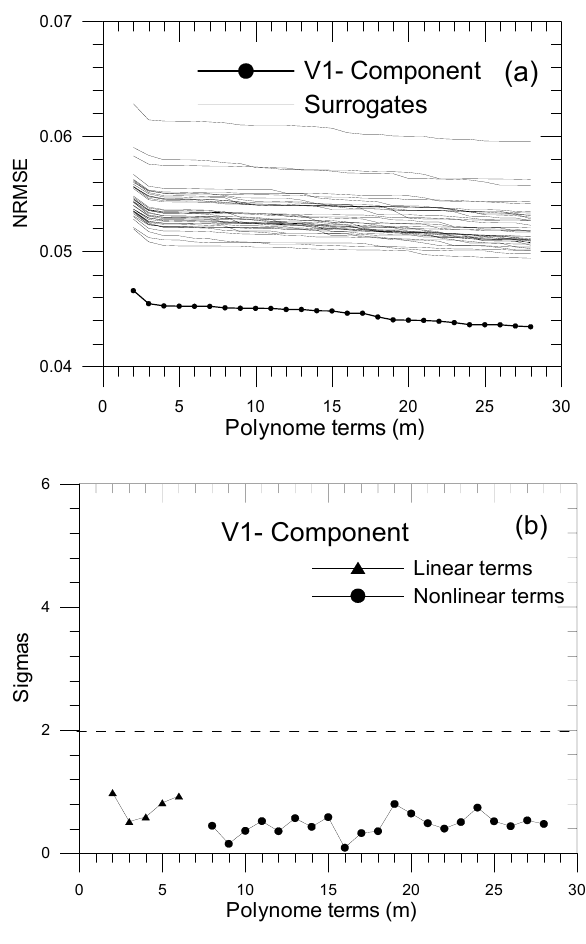
Fig. 11. (a) Normal root mean squares error (NRMSE) estimated by using a polynomial fitting for the V 1 -component time series and its surrogate data, as a function of the polynomial terms of the Voltera- Wiener model estimated for parameters m = 6 ,t = 70 ,q = 2 and 10 steps ahead mappings. (b) Significance of the reduction er- ror statistic corresponding to the difference between the polynomial fitting of the first seven linear terms from the polynomial fitting con- taining all the possible linear-nonlinear